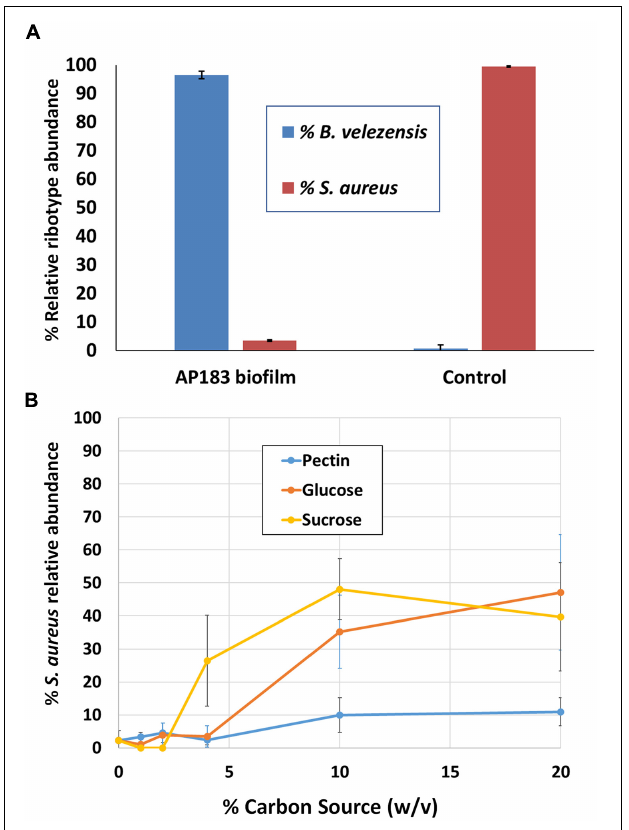
FIGURE 3 | Competition between B. velezensis AP183 and S. aureus NE1260F when (A) the B. velezensis AP183 culture forms a biofilm on a tracheostomy tube inner cannula section prior to inoculation with S. aureus NE1260F, or (B) when B. velezensis AP183 and S. aureus NE1260F are co-inoculated into M9 minimal medium containing either glucose (can be used by both cultures), sucrose (can be used by both cultures), or pectin (can only be used by B. velezensis AP183).